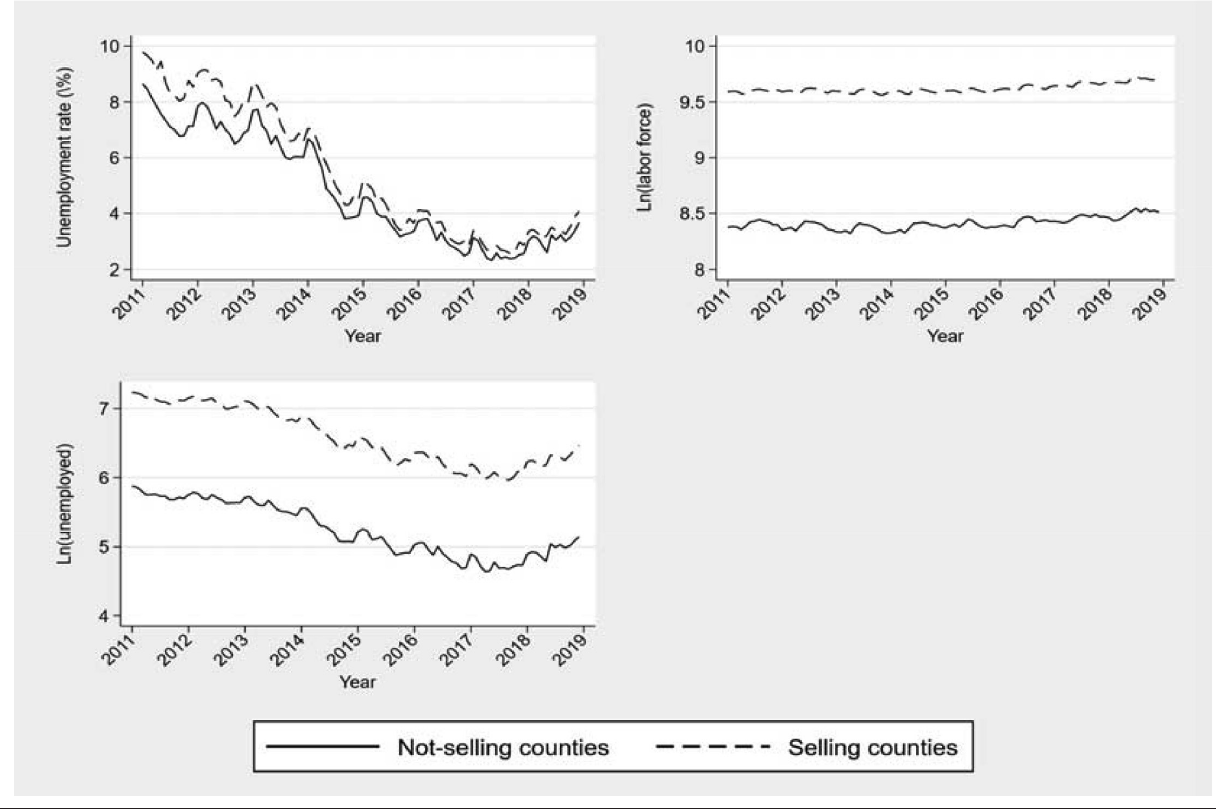
Note : The underlying data were obtained from the Local Area Unemployment